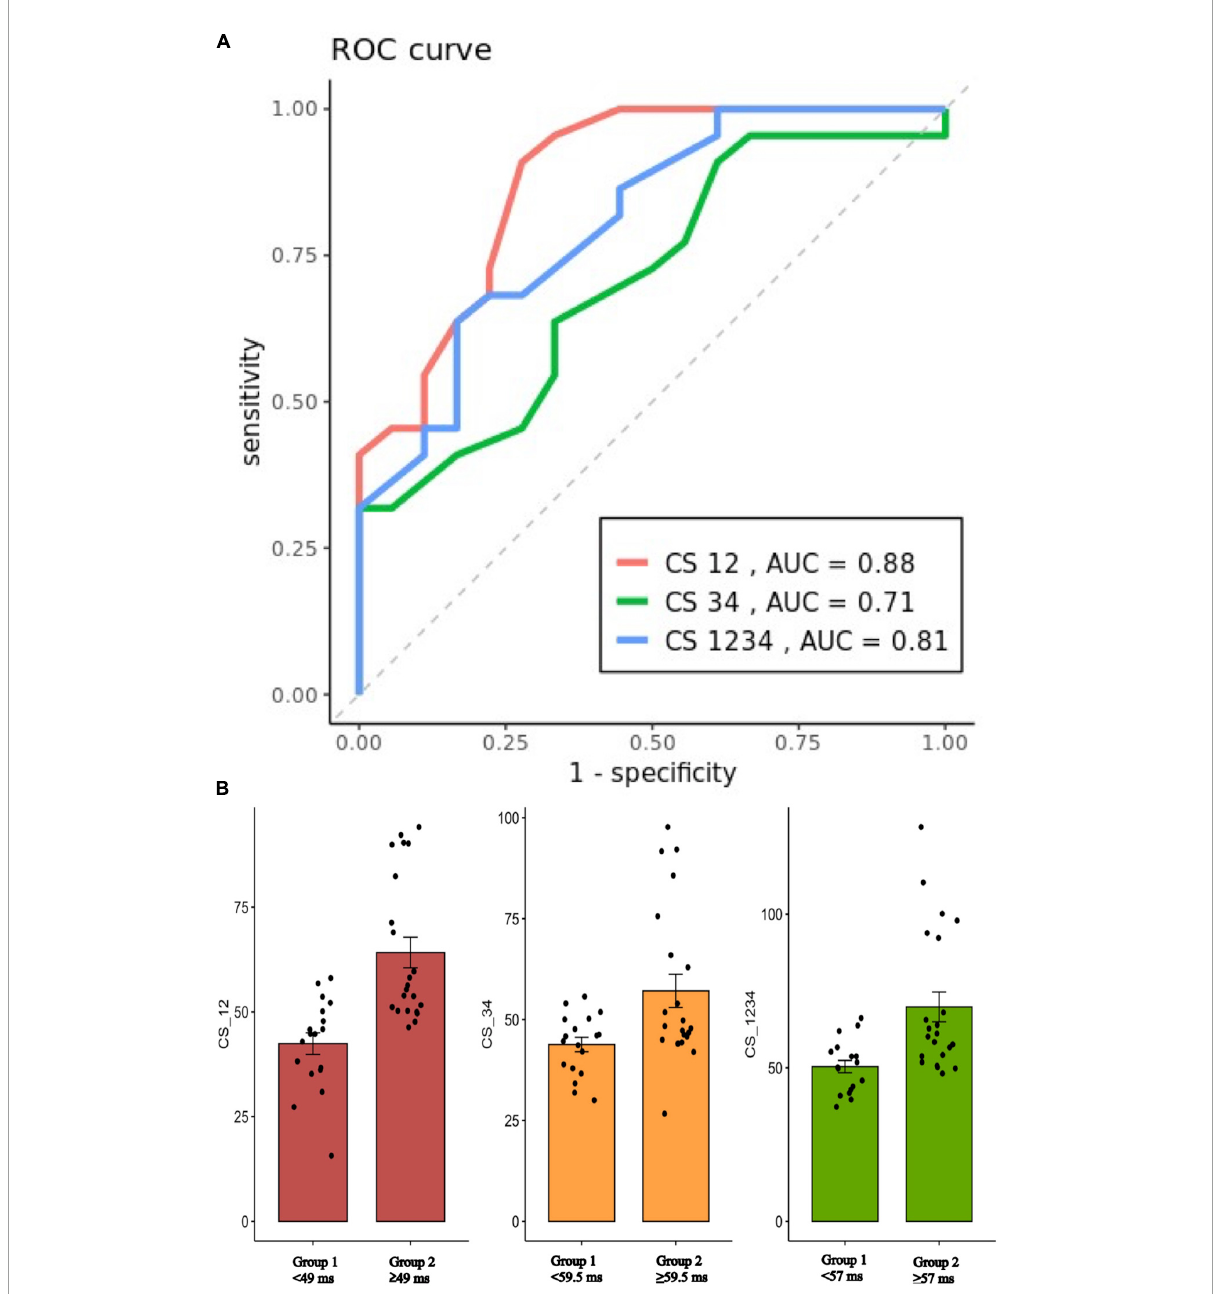
FIGURE4 (A) : ROC curves for prediction of EEB on the CS12, CS34, and CS1234 interval (Cutoff value: 47, 59.5, and 57 ms, respectively). (B) : Scatterplot showing the mean value ± SD of the CS12, CS34, and CS1234 interval (ms) for patients with either group 1 (endocardial success) or group 2 (epicardial success). ROC, receiver operating characteristic; EEB, epicardial breakthrough; CS, coronary sinus; AUC, area under